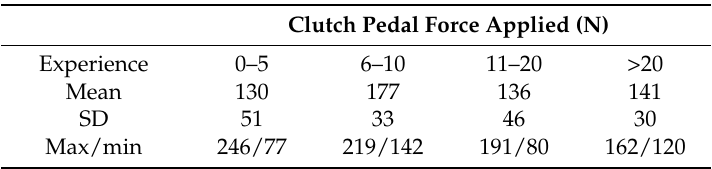
Table 8. Maximum clutch pedal force applied in every range.